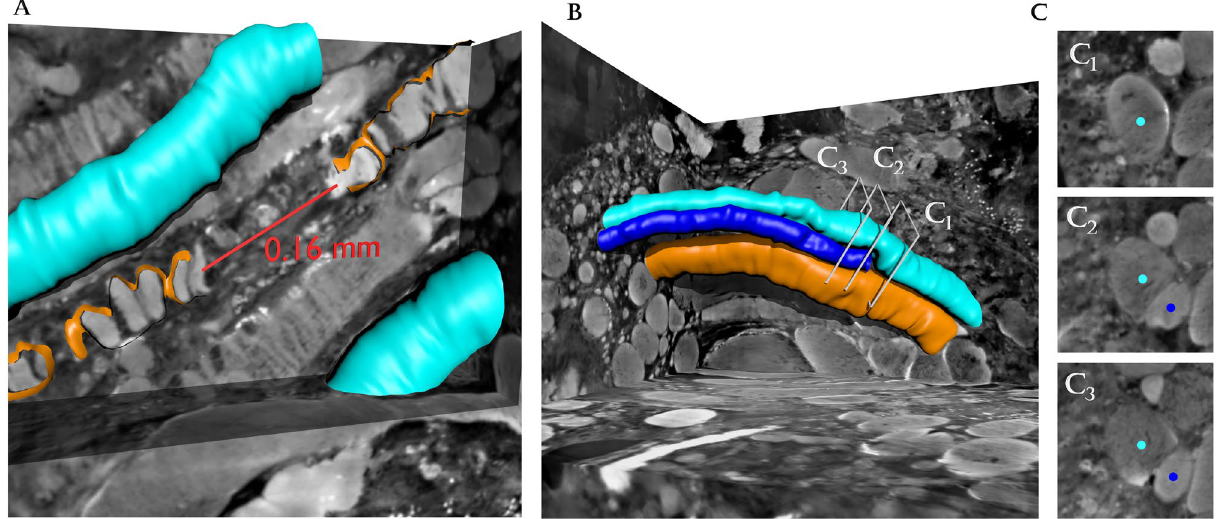
Figure 3. 3D visualization of breaking and splitting fibers within the spinal cord injury sample. ( A ) Muscle fiber breaking: two heavily fractured muscle fibers were observed with a ‘gap’ between them of approximately 0.16 mm. Given the directionality of each segment and the neighboring muscle cells, it appears to be a single muscle fiber split into two. ( B ) Fiber splitting: the cyan fiber appears as one big muscle fiber until it splits into two separate neighboring cells (cyan and blue fibers). The disjoint appearance of the segmented objects is simply an artifact of our segmentation strategy, where each fiber is modeled as a tubular structure with no overlap with its neighbors. In reality, we would expect a smooth fusion from one fiber into two branches of fibers. ( C ) Three cross-sectional slices of the volumes around the merging point, supporting the visual appearance of the splitting. The figure was created using MatLab software (v2020b): https:// www. mathw orks. com/ produ cts/ new_ produ cts/ relea se202 0b. html and Blender software (v2.78c): https:// www. blend er. org/ downl oad/ relea ses/2-